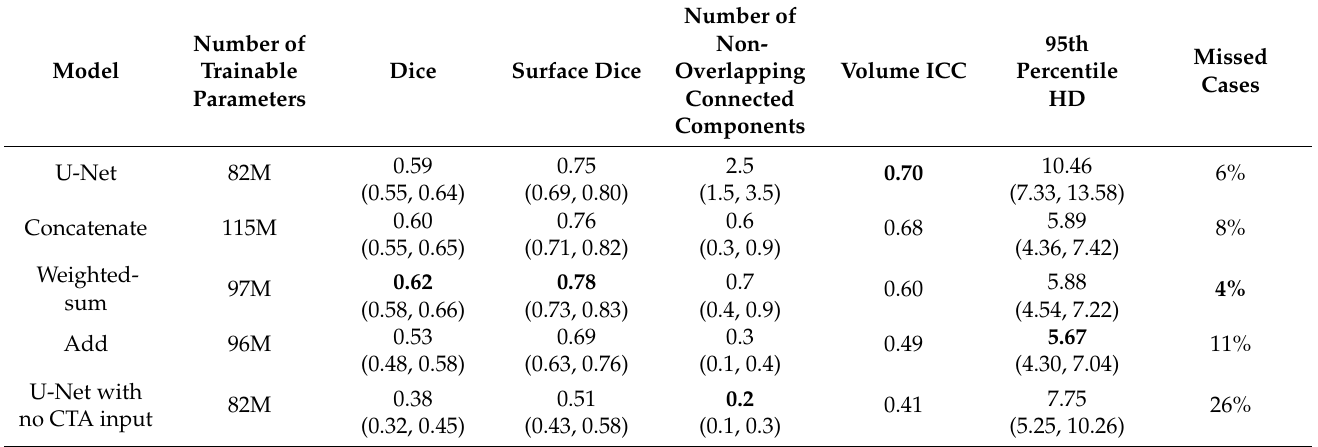
Table 2. Comparing the properties and performance of different segmentation networks. Numbers in the parenthesis show the 95% confidence interval. Best performance in each metric is emphasized by bold text. Missed cases shows the percentage of cases with a Dice = 0 in the test